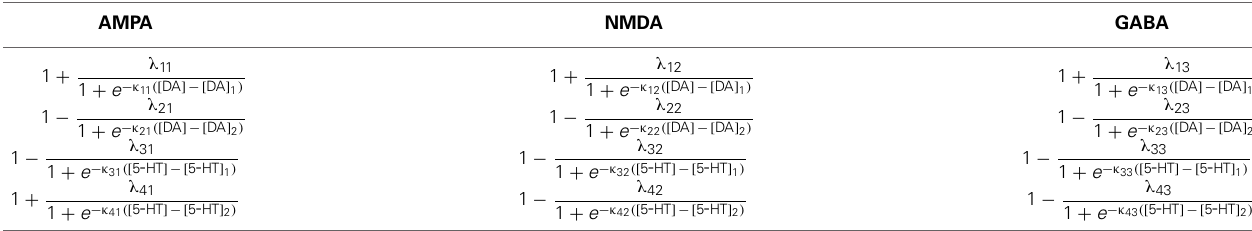
Top to bottom rows: modulation factors due to D1, D2, 5-HT1A, and 5-HT2A receptors, respectively. * As activation of 5-HT1A receptors on an interneuron can reduce GABA release, an assumption is made in which GABA-mediated currents are modulated only by presynaptic 5-HT1A receptors on an interneuron and not postsynaptic 5-HT1A receptors.